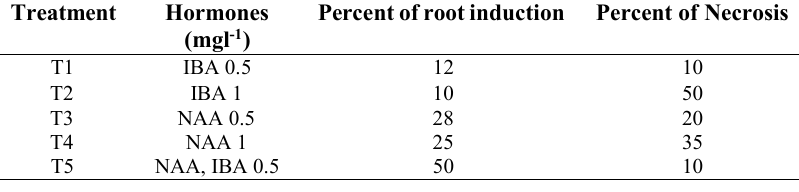
Table 6. Effect of hormone treatments on root induction Means